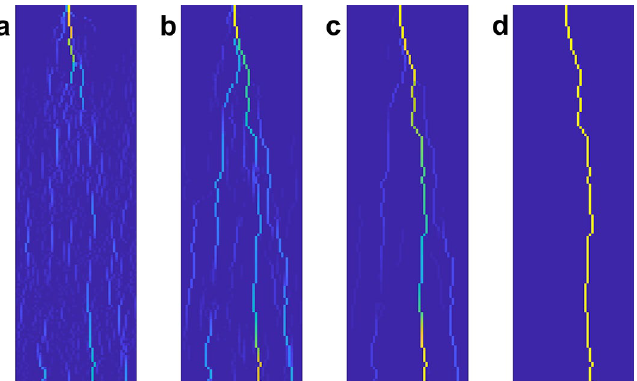
Figure 4. The lightning transient phases. Several branches are initially generated by the stepped leader ( a ); the stepped leader meets a connecting leader and the cloud is connected with the ground ( b ); only the main branch path persists, corresponding to the optimal path w.r.t. J h ( c ); the optimal path is crossed by the long-duration current, steady state ( d ). The color map goes from blue (no current) and light blue (low intensity current) to yellow (high intensity